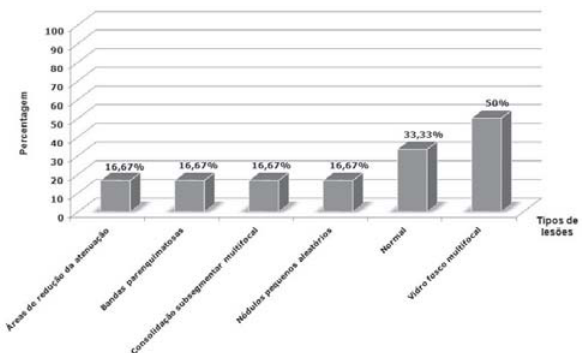
Fig. 1 - Porcentagem dos achados tomográficos nos pacientes tratados clinicamente para oclusão do canal arterial (grupo